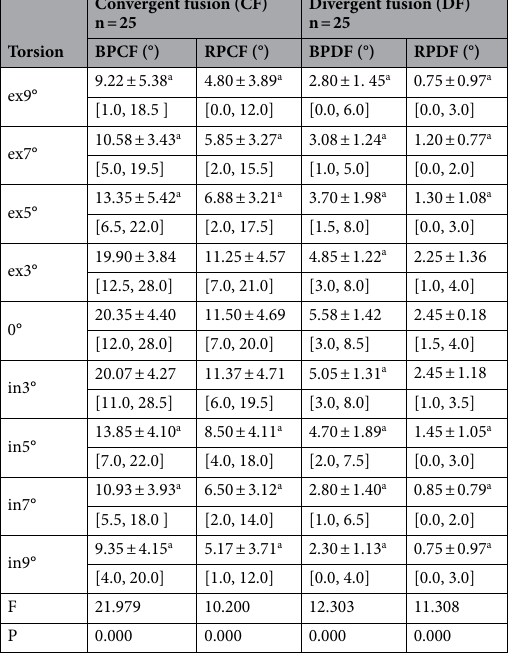
Table 1. BPCF, RPCF, BPDF and RPDF of p-F at different rotations. ex, extorsion; in, intorsion. a P < 0.05 comparison with the value in the baseline (0°) by Tukey multiple comparison